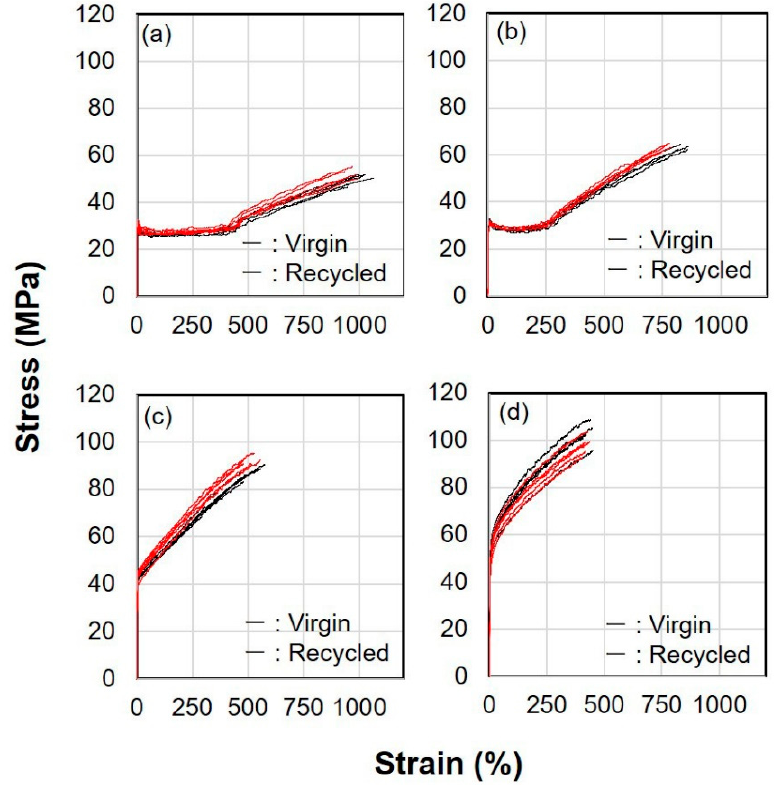
Figure 6. Stress–strain curves for the virgin and recycled PP fibers melt spun at different take-up velocities; ( a ) 0.5 km/min, ( b ) 1.0 km/min, ( c ) 3.0 km/min and ( d ) 5.0 velocities; ( a ) 0.5 km/min, ( b ) 1.0 km/min, ( c ) 3.0 km/min and ( d ) 5.0 km/min.